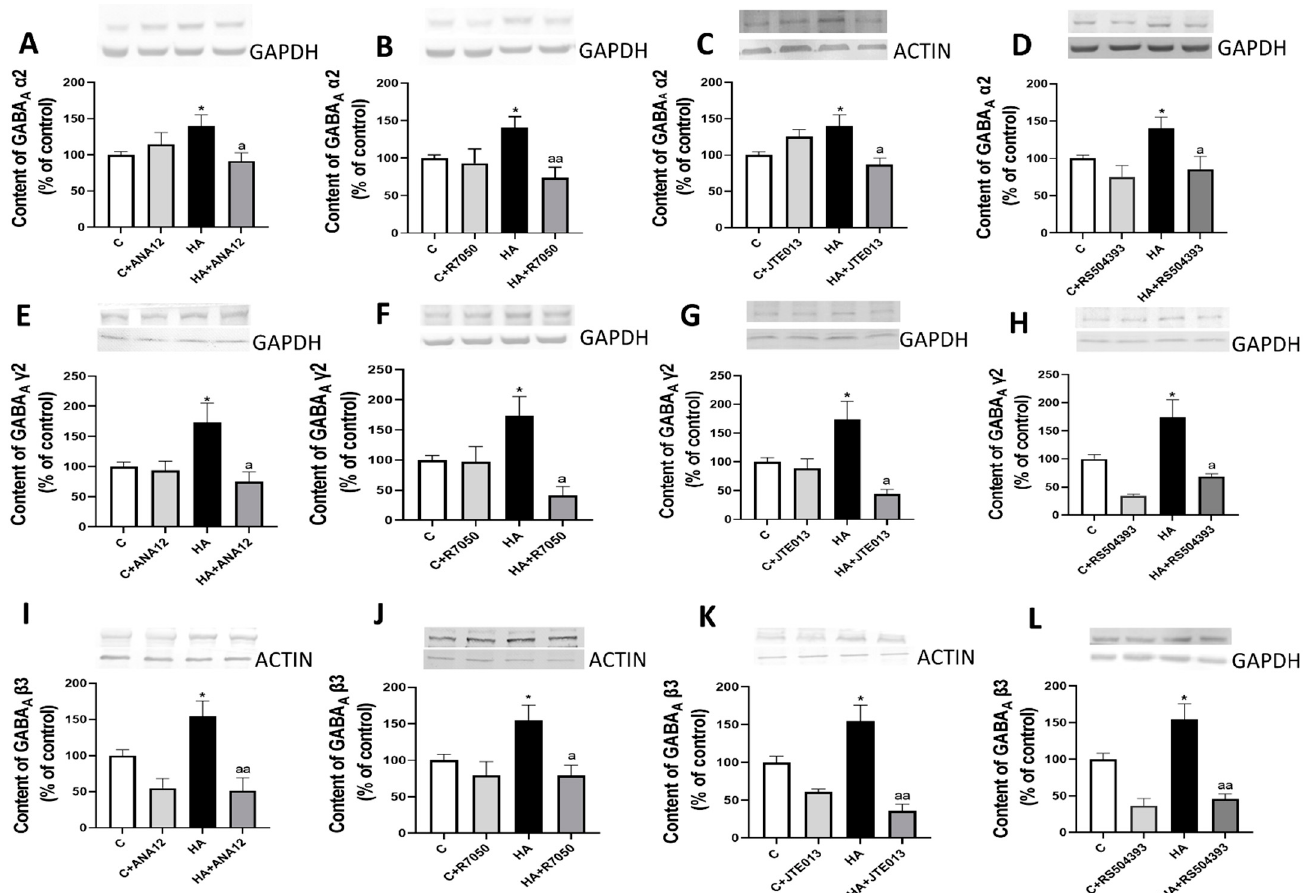
Figure 8. Hyperammonemia increases the content of GABAA receptor subunits α 2, γ 2, and β 3 in the cerebellum. Ex vivo treatment with ANA12, R7050, JTE-013, or RS504393 reverses these increases. The total content of GABAA receptor subunits ( A – D ) α 2, ( E – H ) γ 2, and ( I – L ) β 3 in the cerebellum of control (C) and hyperammonemic (HA) rats was analyzed with Western blot. The effects of blocking TrkB with ANA12, TNFR1 with R7050, S1PR2 with JTE-013, or CCR2 with RS504393 on the content are also shown. Values are the mean ± SEM of 18–26 rats per group. Values significantly different from control rats are indicated with asterisks, and from hyperammonemic rats are indicated with “a”. * p < 0.05, ** p < 0.01; a p < 0.05, aa p < 0.01. ( A – L ) F values were 3.825, 5.274, 4.670, 5.303, 3.753, 3.720, 3.805, 5.340, 7.284, 4.487, 6.564, and 7.261, respectively. Data were analyzed using one-way analysis of variance (ANOVA) followed by Tukey’s post hoc